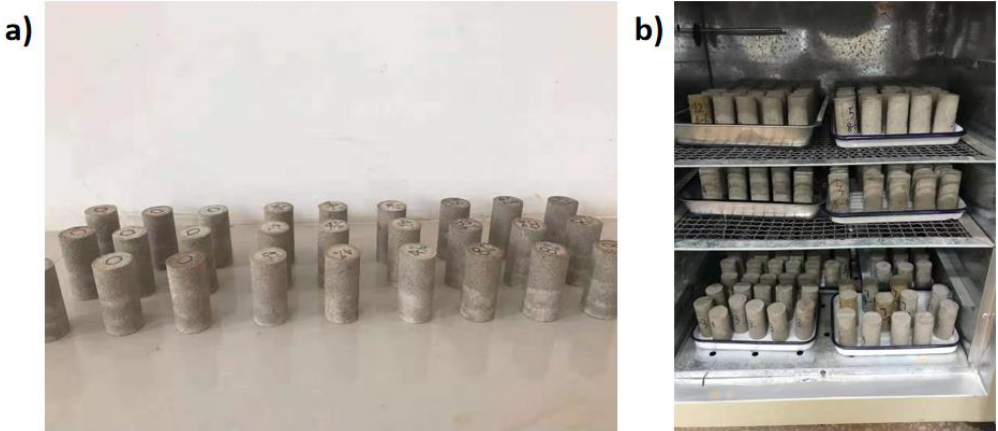
Figure 3. The prepared cylinder samples for the mechanical and durability tests. ( a ) The cylinder samples prepared with original Pisha sandstone/W-OH composites; ( b ) indication of the convection oven for sample drying.